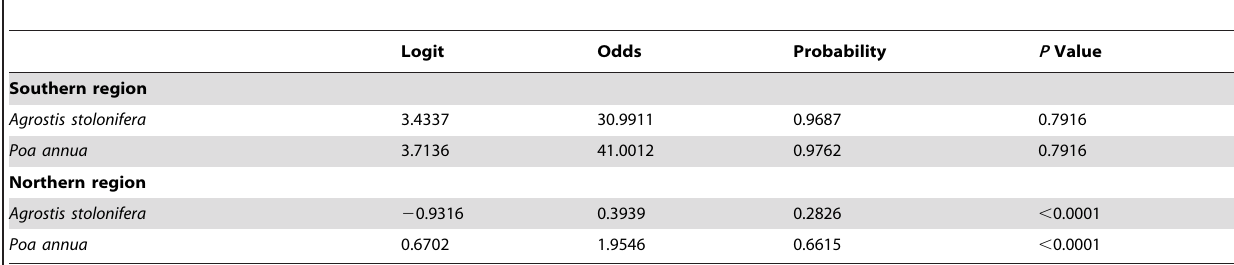
Table 5. Exact logistic regression results on the probability of samples diagnosed as Colletotrichum cereale clade A across regions and turfgrass